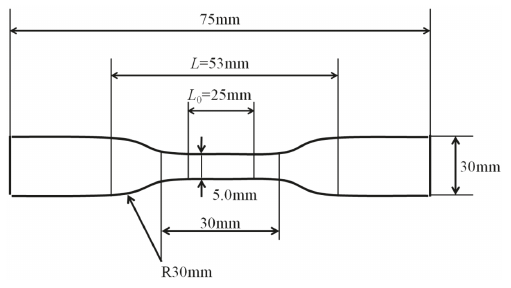
Figure 1: Dimensions of the sample used in the tensile test.